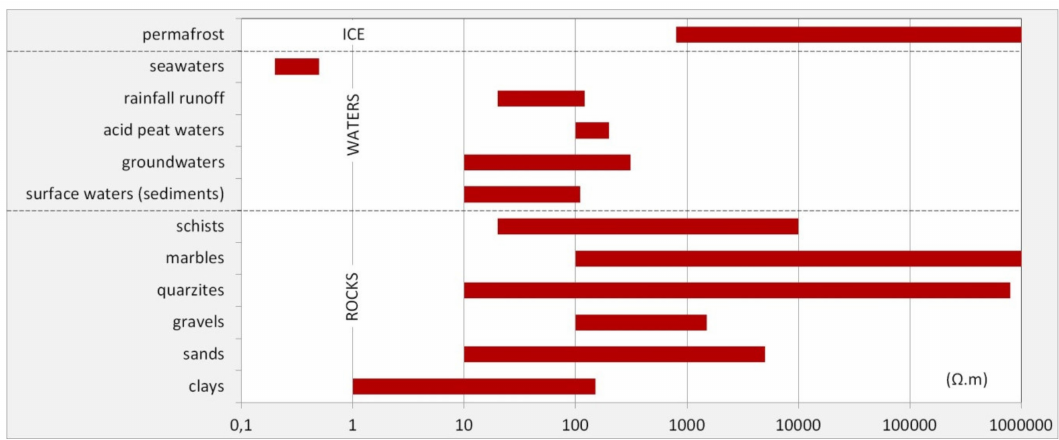
Figure 3. Range of resistivity for di ff erent materials. Compilation based on